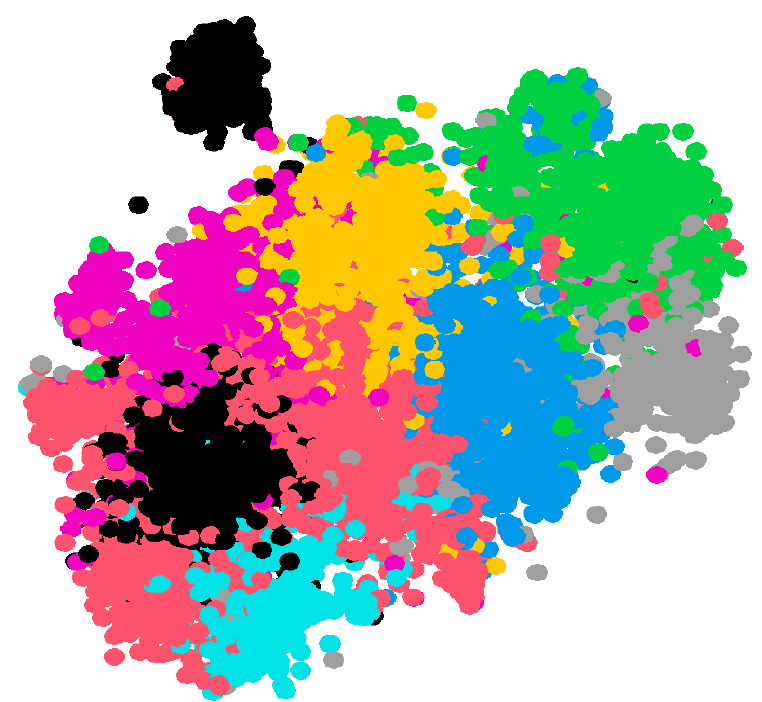
Figure 11. t-SNE representation of points corresponding to digital images of COVID-19 pandemic. Figure 11. Digital image containing 10,000 images regarding the COVID-19 pandemic (2 × 2 m). © Pilar Rosado.